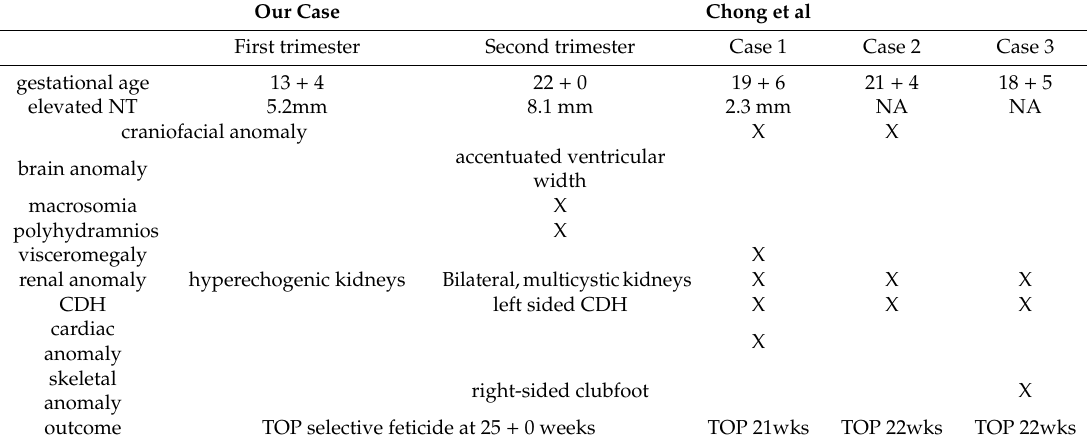
Table 1. Summarized ultrasound and MRI findings in Simpson-Golabi-Behmel syndrome (SGBS) type 1 compared with the cases of Cong et al.,